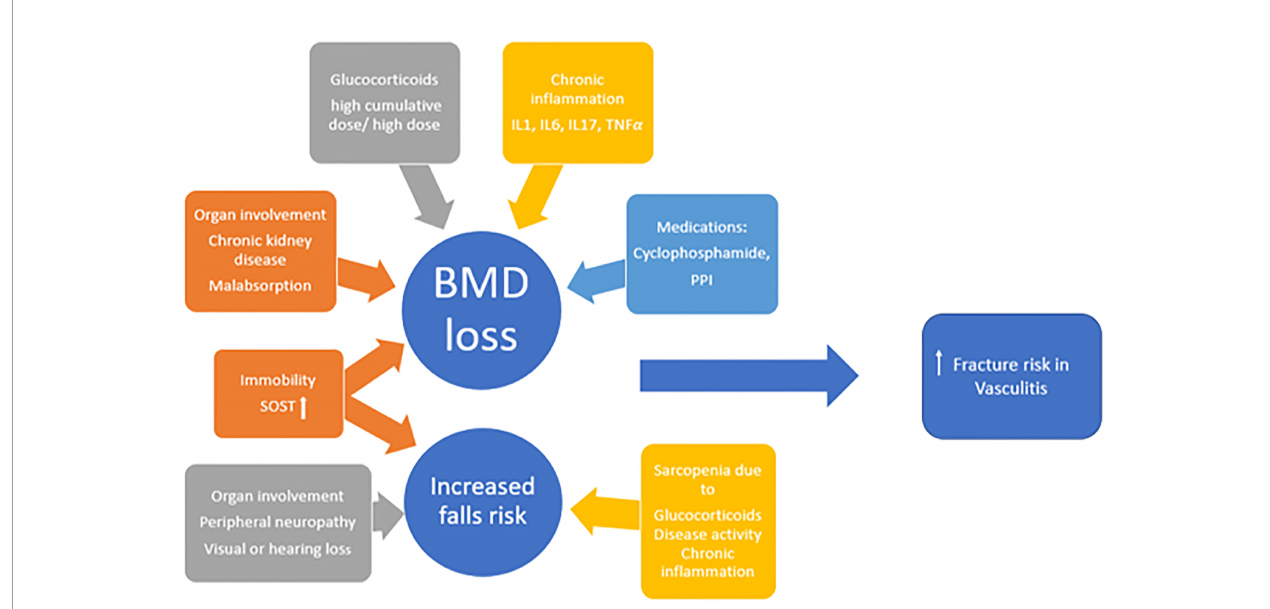
FIGURE 2 | The multifactorial aetiology of increased fracture risk in vasculitides; IL interleukin, TNF tumour necrosis factor, PPI proton pump inhibitor, SOST sclerostin, BMD bone mineral